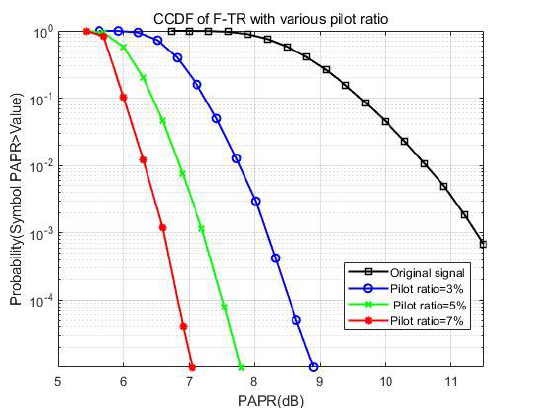
Figure 6. CCDF of F-TR with various pilot